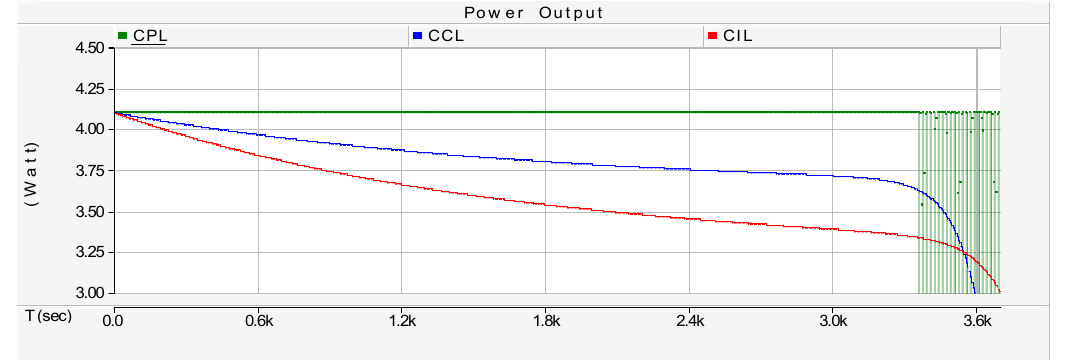
Figure 16. Instantaneous output ‐ power at the battery terminal.